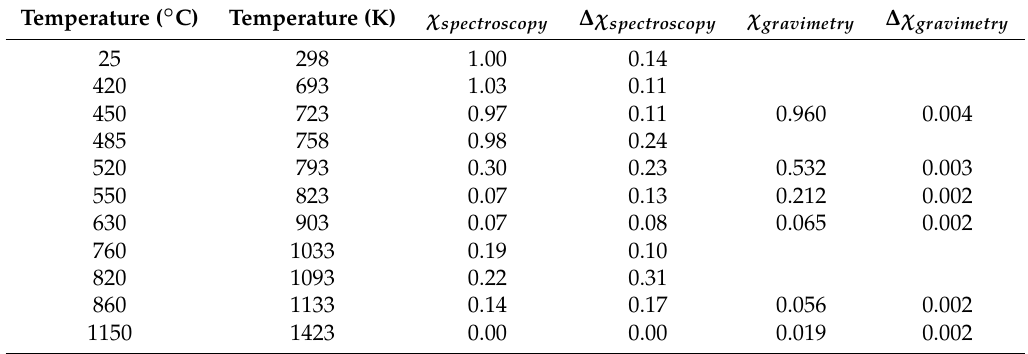
Table 1. Selected temperatures (in ◦ C and K) and experimental values of χ spectroscopy and χ gravimetry with respective uncertainties for the sample